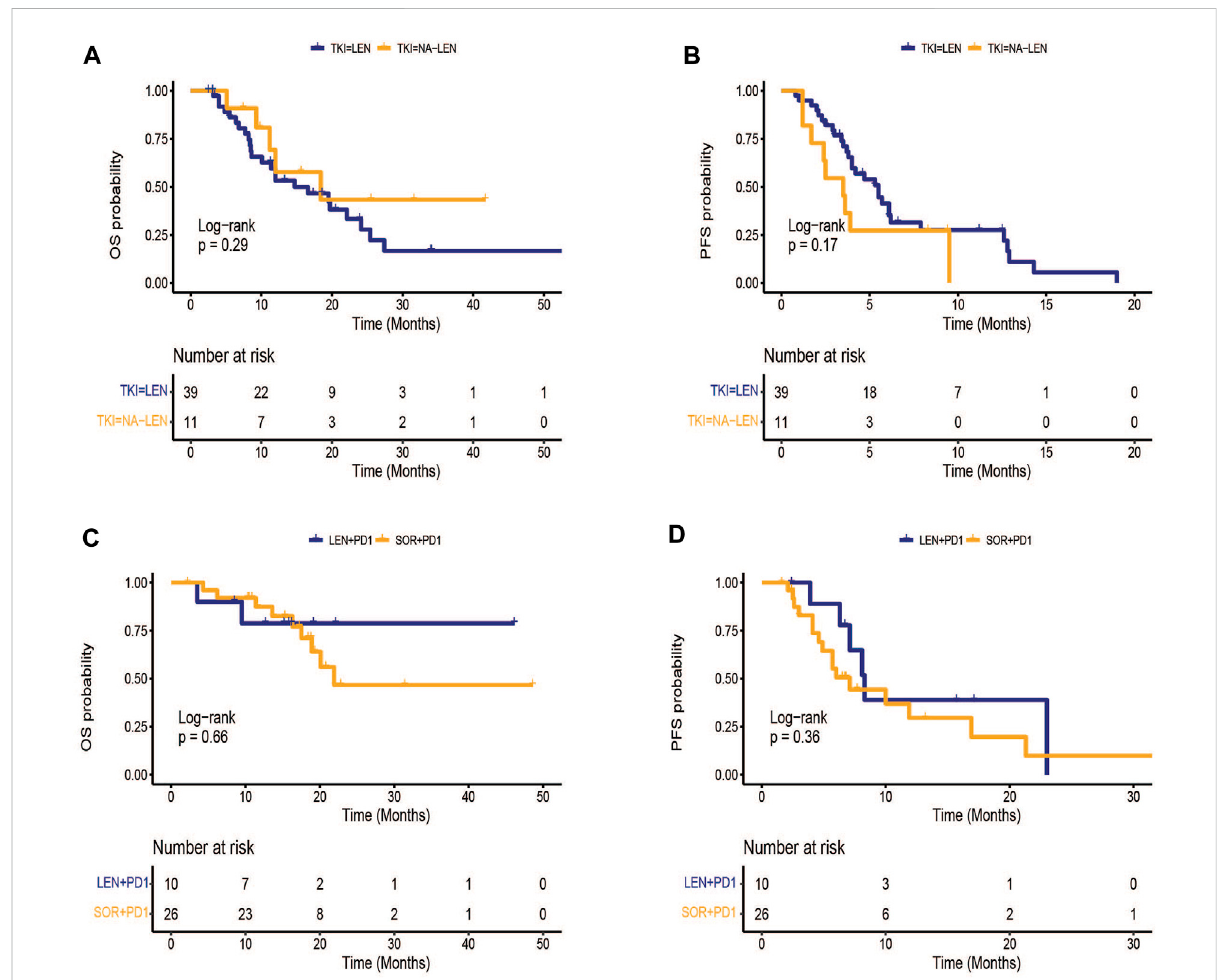
FIGURE 2 Kaplan-Meiersurvivalcurvesoftreatment outcomeincluding (A) overall survival(OS), (B) progression-freesurvival(PFS)betweenlenvatiniband other TKI groups, (C) OS, (D) PFS between sorafenib plus PD-1 inhibitors and lenvatinib plus PD-1